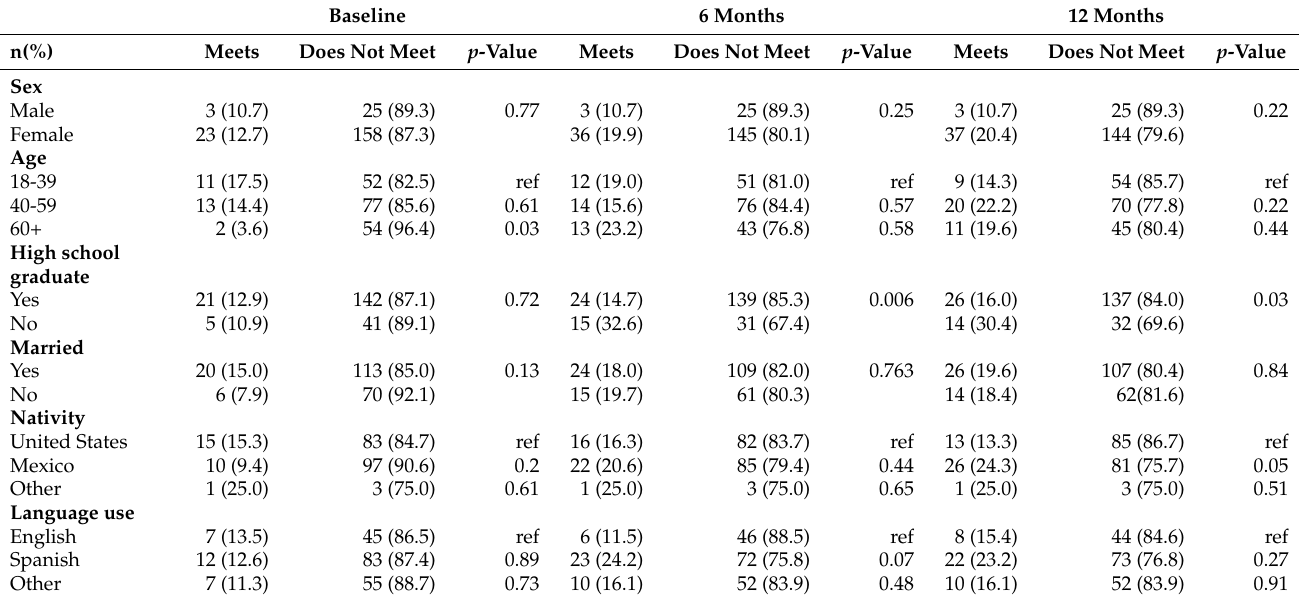
Table 2. Participants who met the guidelines for moderate physical activity by